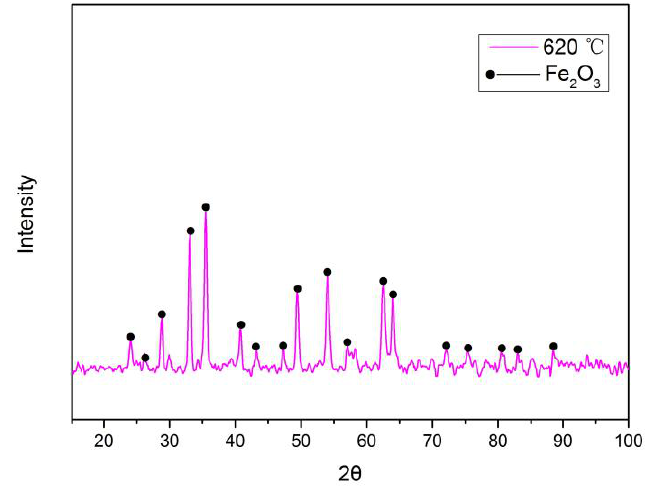
Figure 7. Phase analysis of sintered parts prepared at 620 °C.